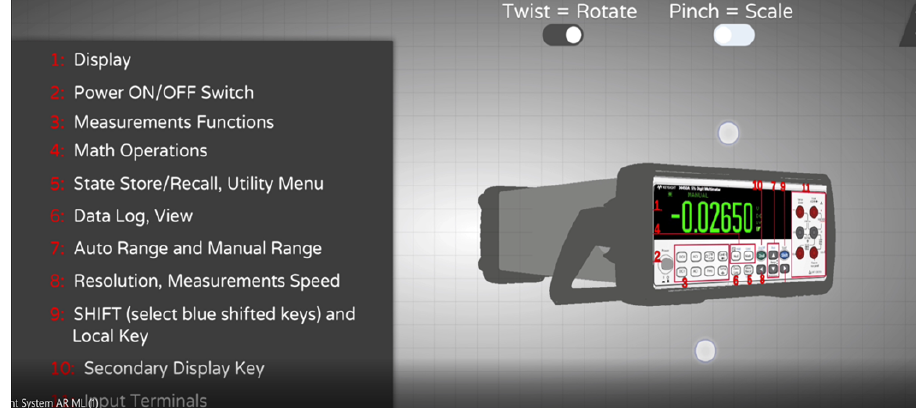
Figure 8. Learning interactive